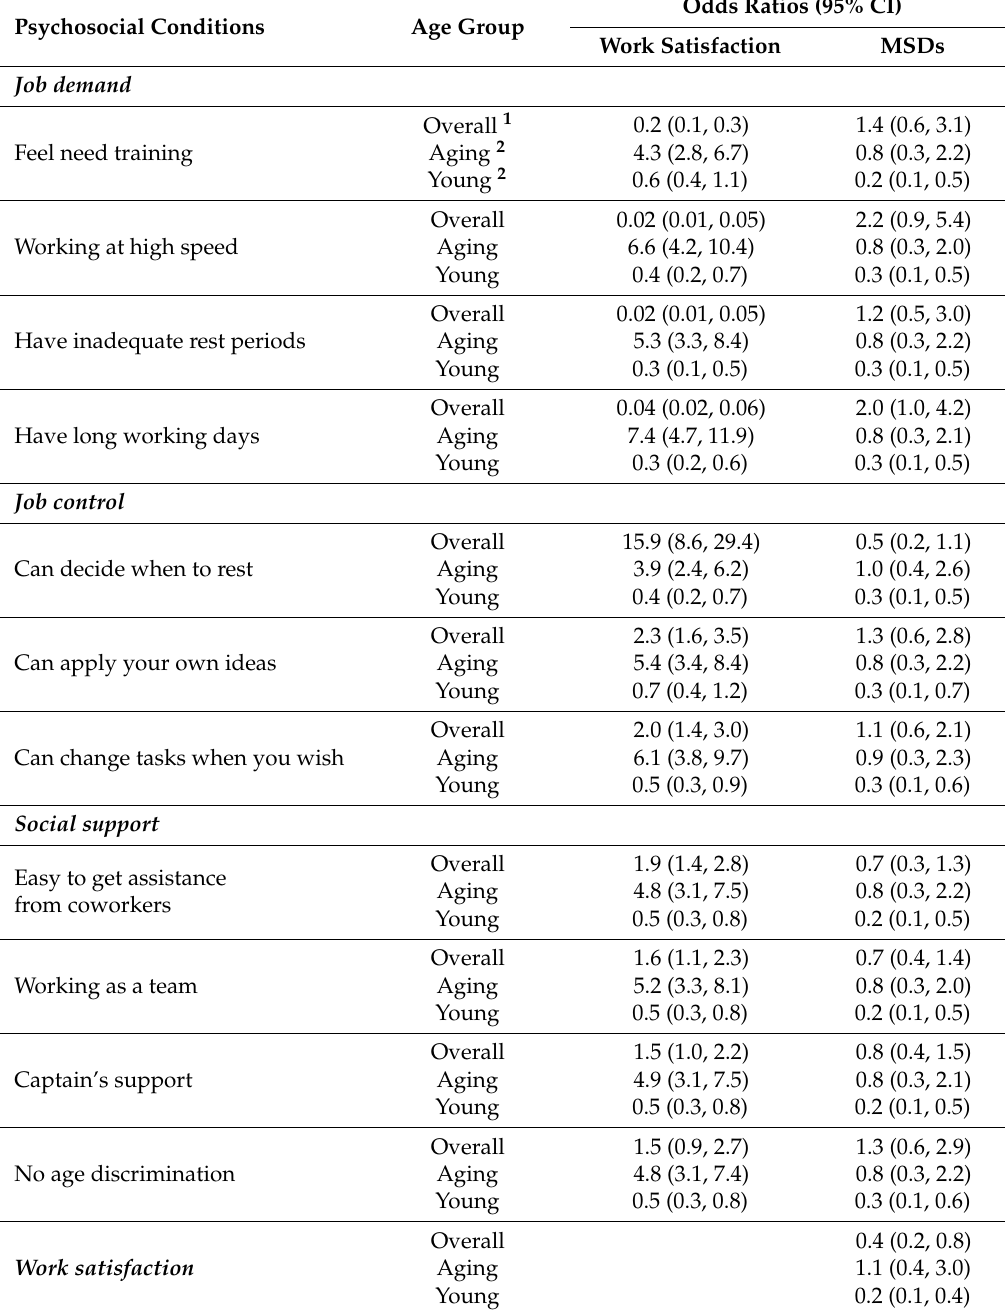
Table 5. Logistic regression analysis of the association of age groups and psychosocial conditions (as predictors) with work satisfaction and MSDs (as